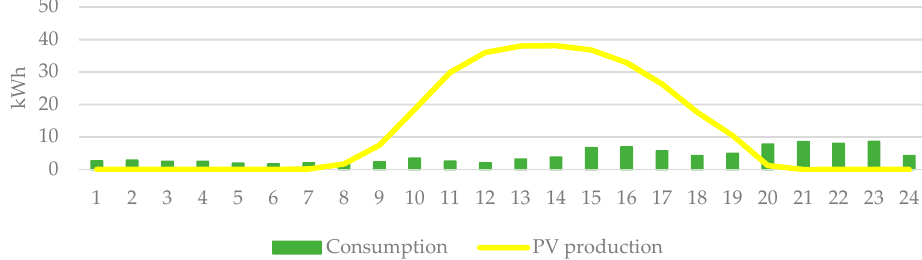
Figure 4. Comparison between the sum of the hourly energy consumption data of a reference household and the sum of the hourly available surplus renewable generation data from the 4 public buildings in Alfândega da Fé per household during the 6-month trial period. Source: Authors’ own elaboration.